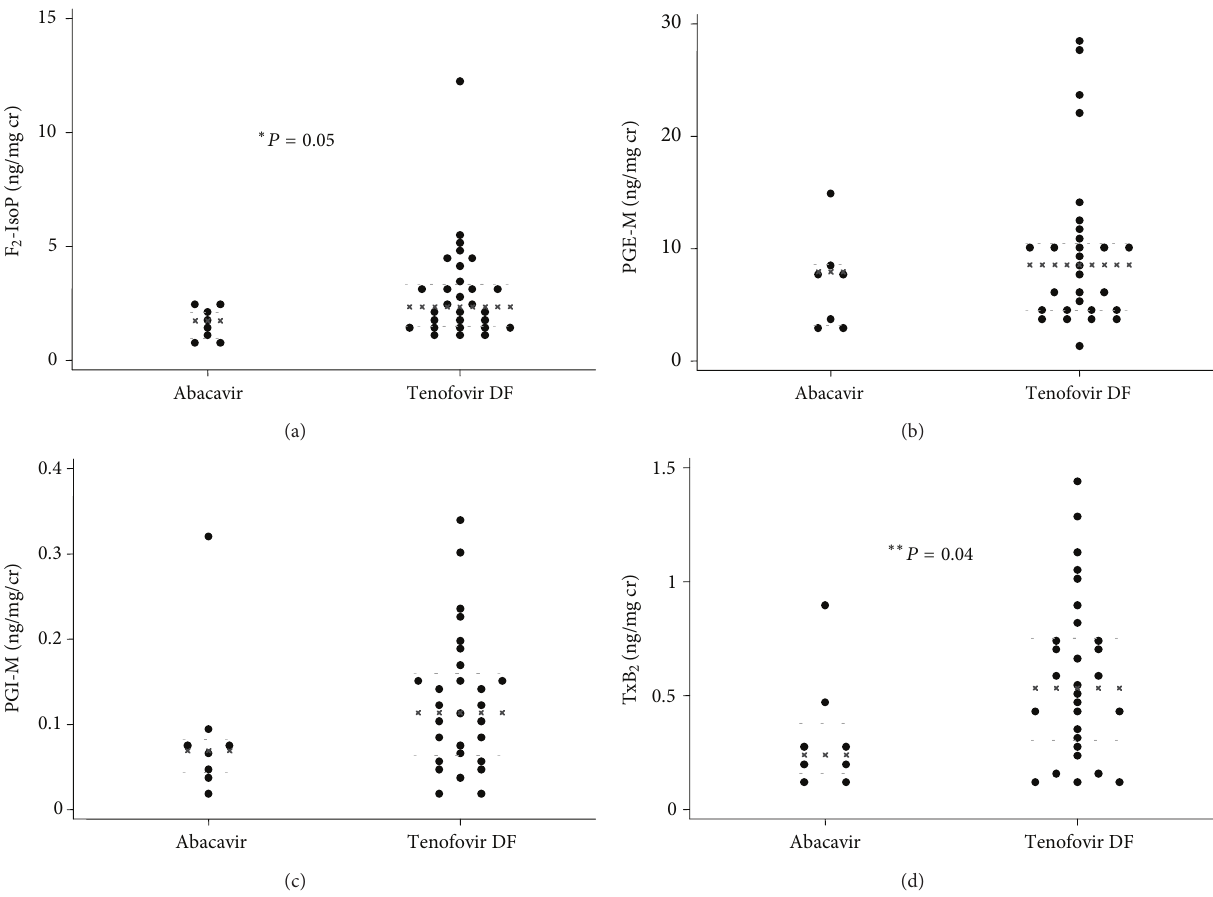
Figure1:Medianbaselineurinaryeicosanoidlevelsbynucleosidereversetranscriptaseinhibitoruse.Panel(a)showsF 2 -IsoP;Panel(b)shows PGE-M; Panel (c) shows PGI-M; Panel (d) shows TxB 2 . ∗ 𝑃 value = 0.05; ∗∗ 𝑃 value = 0.04. Black (x) lines indicate within-group median; grey dashed lines (-) indicate within-group 25th and 75th percentiles. F 2 -IsoPs: F 2 -isoprostanes; PGE-M: prostaglandin E 2 metabolite; PGI-M: prostacyclin metabolite; TxB 2 : thromboxane B 2 . Units are ng/mg creatinine.